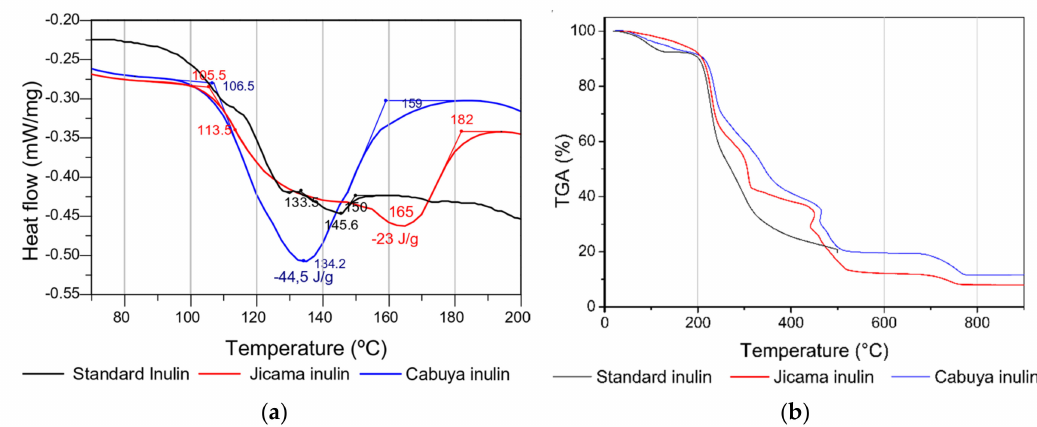
Figure 7. Plots of the thermal analyses of the commercial inulin (standard) and extracted inulin: ( a ) DSC and ( b ) TGA.